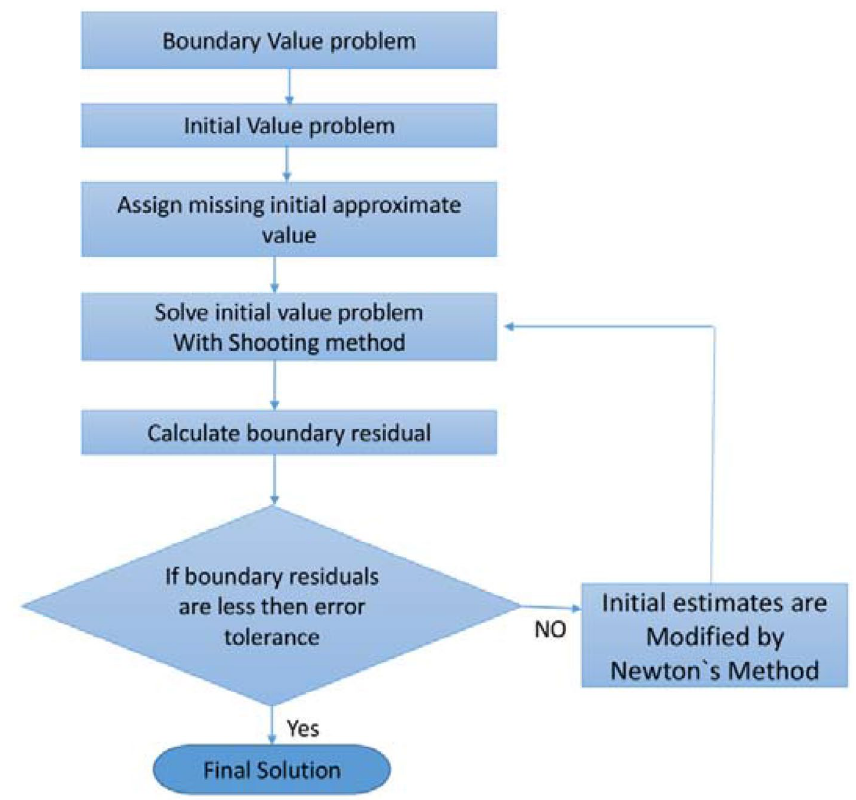
Figure 2. Flow chart of the numerical